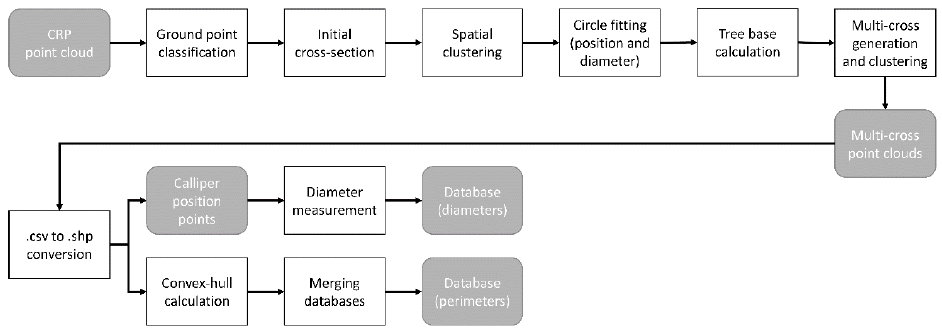
Figure 5. Workflow diagram of the point cloud data processing to the resulted perimeters and diameters of trees.